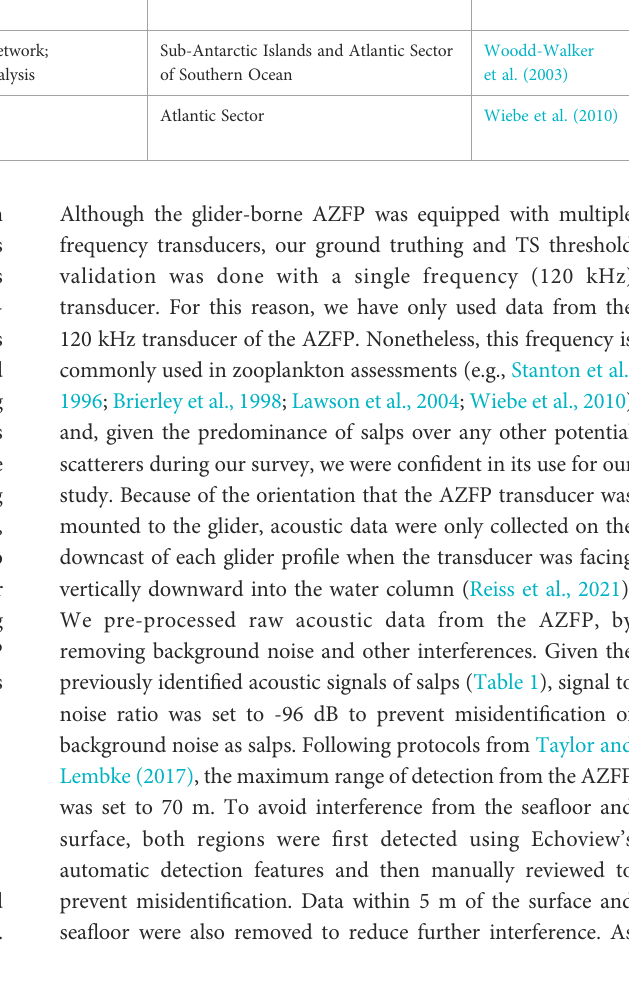
TABLE 2 Mean ± SD of Nautical Area Scattering Coef fi cient (NASC; m 2 nmi -2 ; values per organism group not PRC NASC), volume backscattering strength (Sv; dB re 1 m -1 ), area (m 2 ), and length (m) of detected salp groups and krill aggregations.